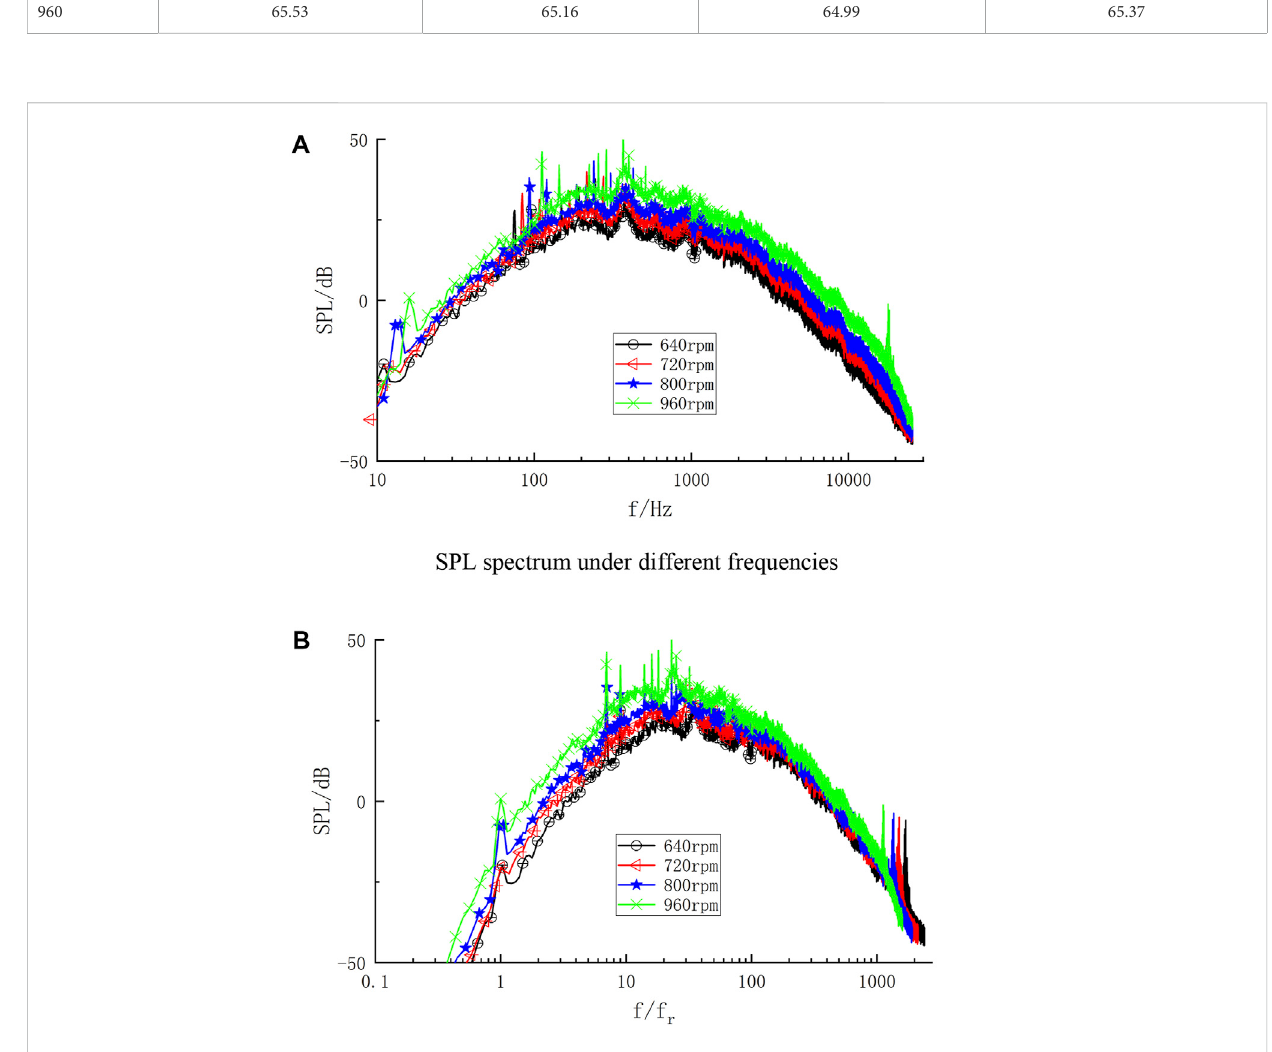
FIGURE 6 SPL spectrum of the contra-rotating axial fan at different rotational speeds: (A) original SPL spectrum; (B) nondimensional SPL